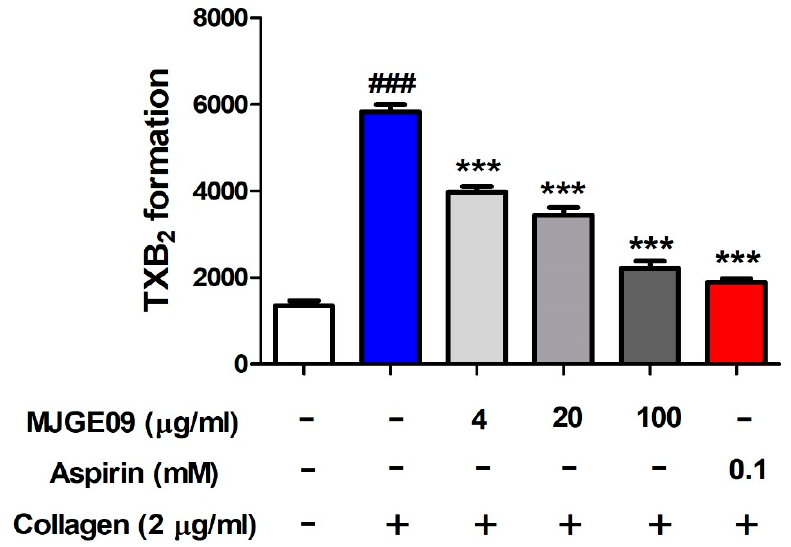
Figure 4. Effects of MJGE09 (4, 20, and 100 µ g/mL) on collagen-induced TXB 2 formation in rat platelets. TXB 2 formation was determined by the TXB 2 EIA kit. After pre-incubating the platelet suspensions with saline, MJGE09 (4, 20, and 100 µ g/mL) or aspirin (0.1 mM), 2 µ g/mL collagen was added. Then, ethylenediaminetetraacetic acid (EDTA) (10 mM) was added to stop TXB 2 formation. Data represent means ± S.E.M ( n = 6). Statistical significance was set at ### p < 0.001 when compared with the control group, and *** p < 0.001 when compared with only the collagen treatment group.